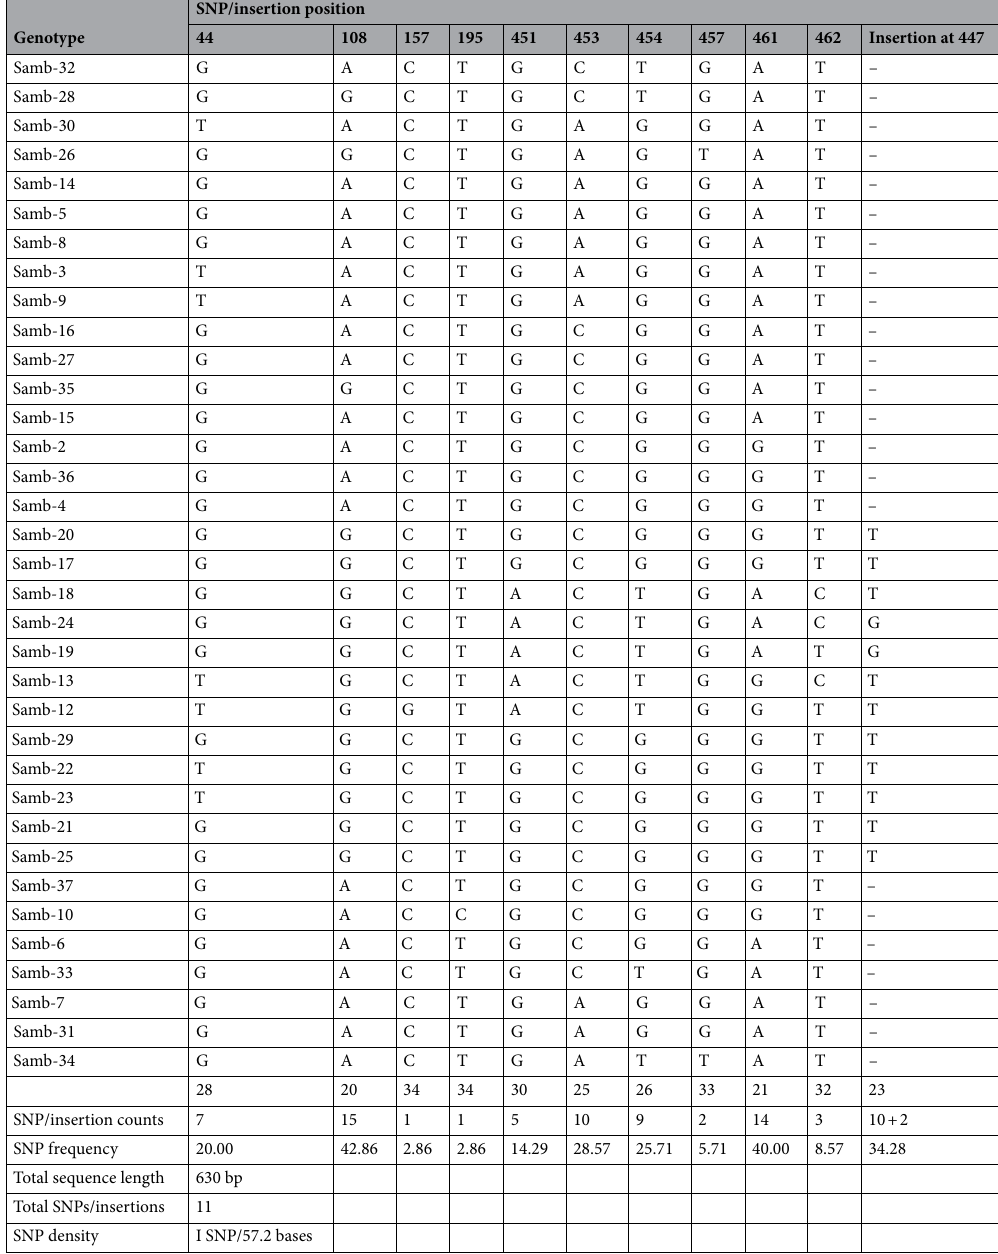
Table 7. List of SNPs detected in the ITS sequences of S. wightiana